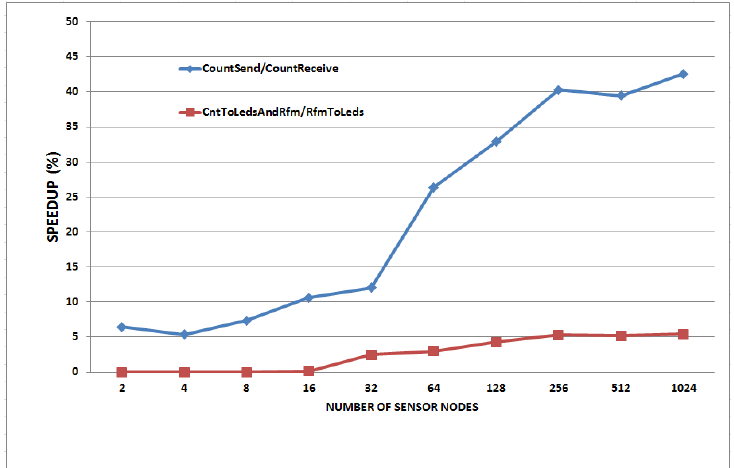
Figure 7. Simulation speedup with various numbers of nodes (1 sender, N receivers).